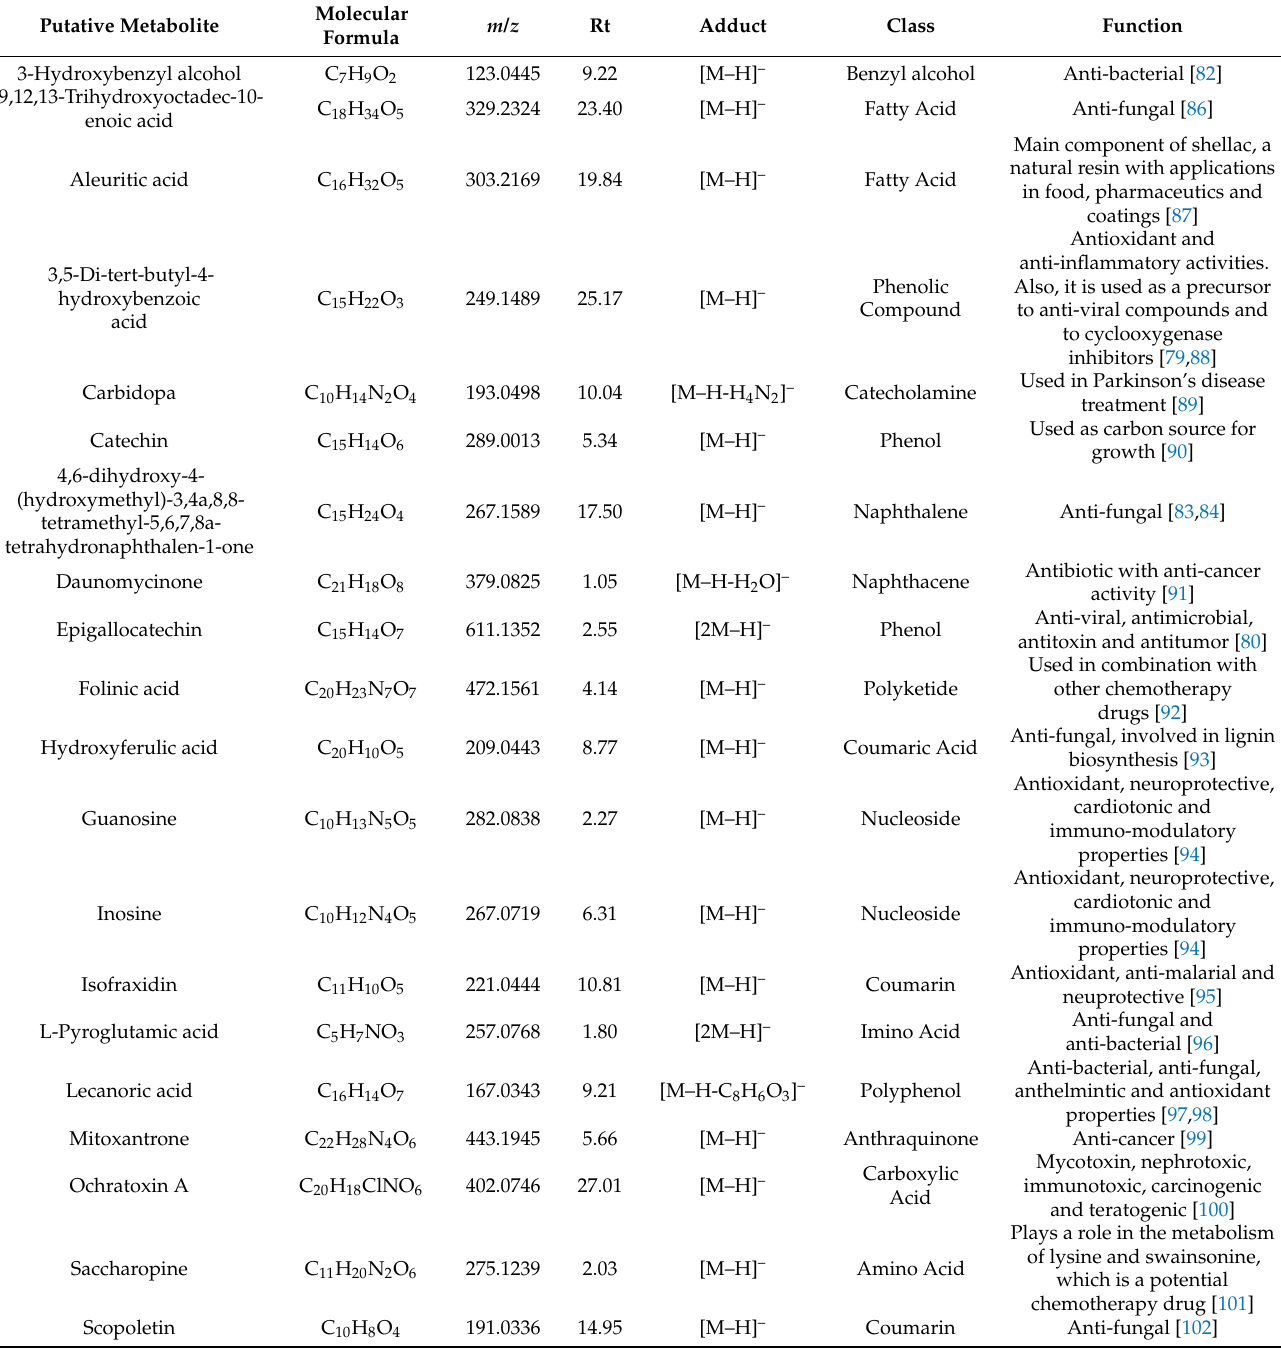
Table 5. Metabolites with biotechnological potential of Aspergillus affinis CMG70 belonging to various chemical classes and related functions. Metabolites were annotated at MSI-level 2. m/z —ratio mass/charge detected; Rt—retention time (min). PubChem was used for class